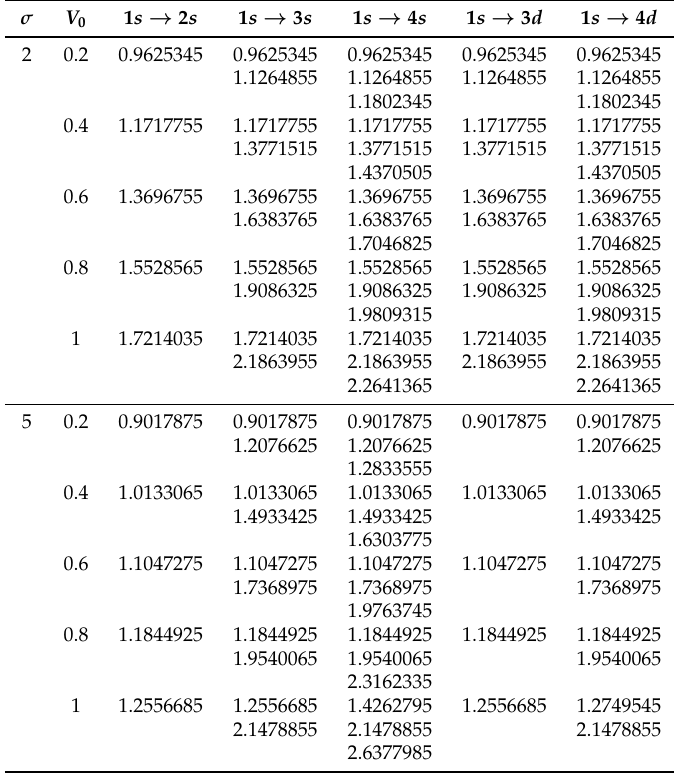
Table 4. Two-photon resonance enhancement frequencies for various potential widths and depths. The data is in atomic